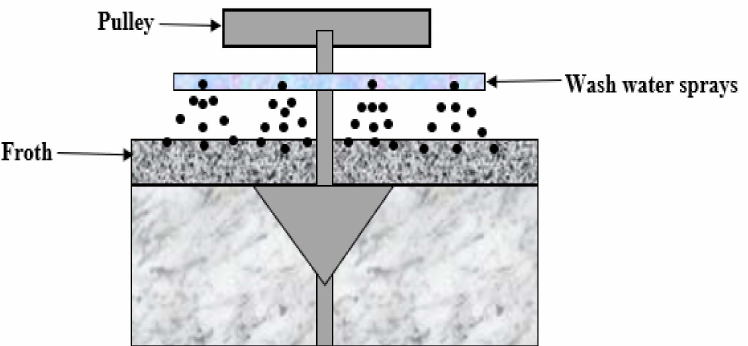
Figure 4. Perforated pipes on top of the froth [39].